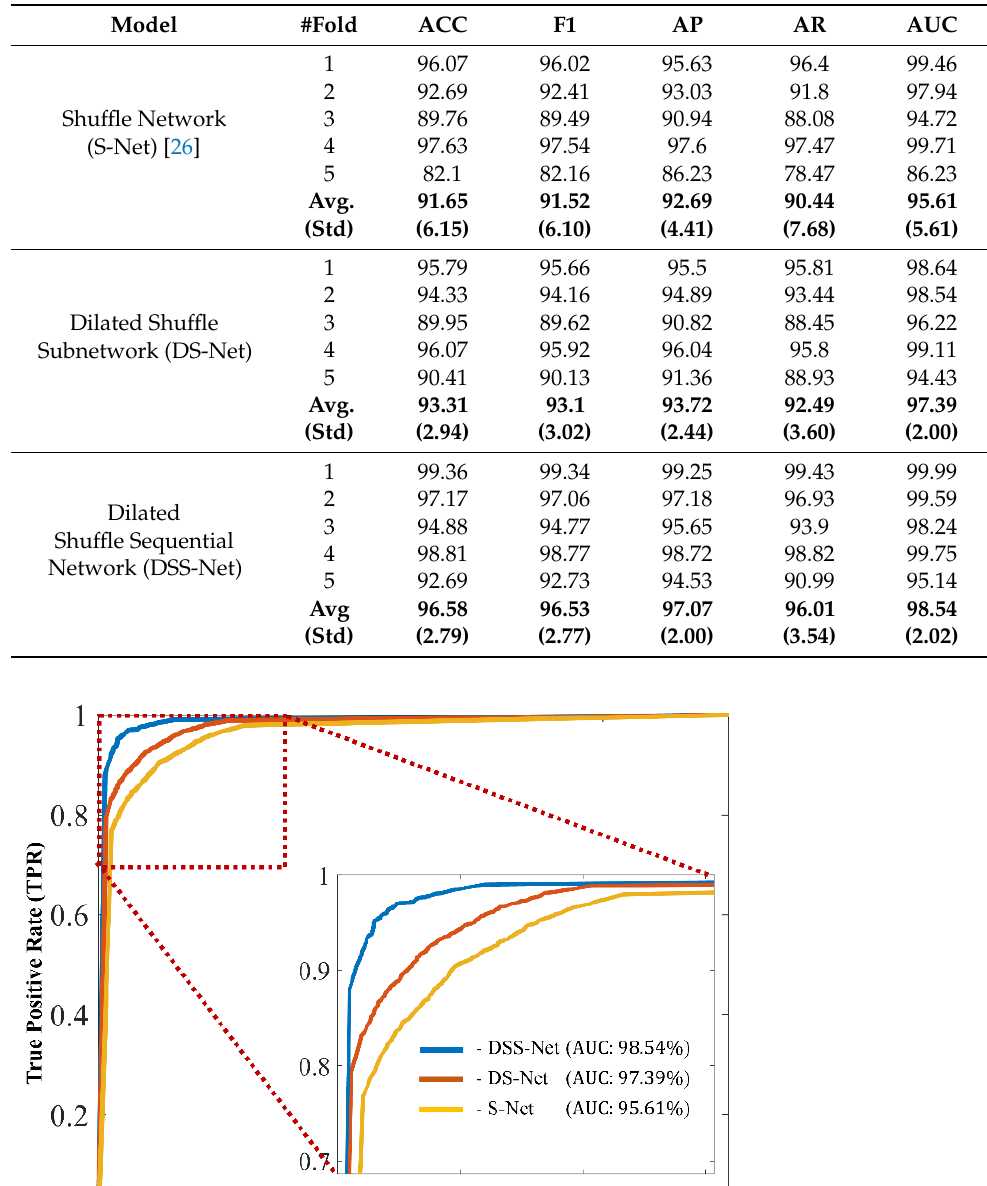
Table 2. Quantitative performance comparison of DSS-Net, DS-Net, and S-Net. The average results are highlighted in boldface. (“#: The number of”, “Avg.: Average”, “Std: Standard deviation”, “unit: %”).